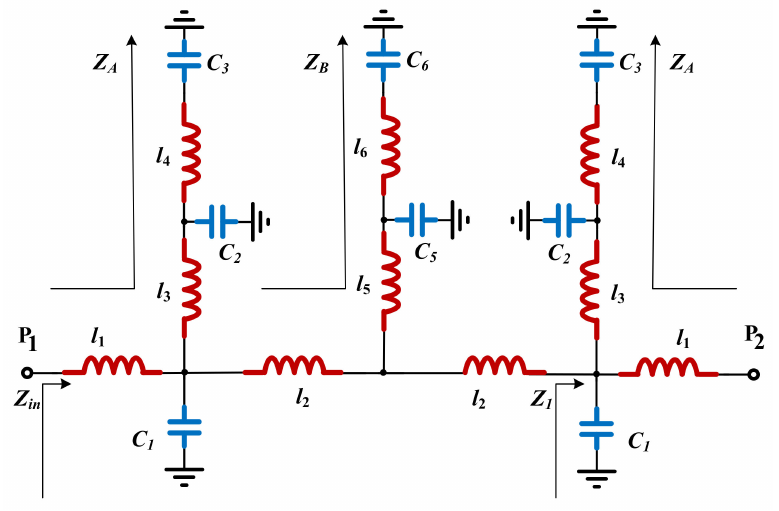
Figure 7. Extracted LCE model of the proposed vertical resonator. Table 1. Obtained values for the applied lumped elements of the LC model of the resonator.